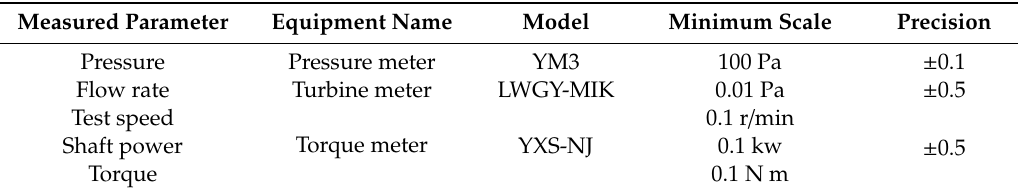
Table 5. Instruments for